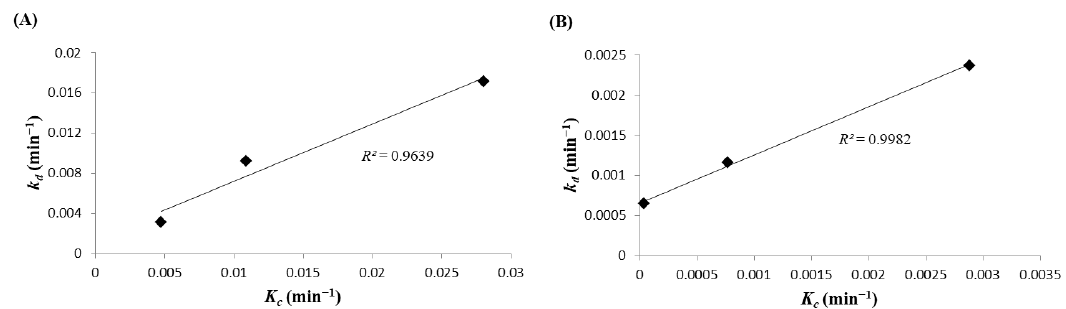
Figure 3. Relationship between crystallization rate constant K c and destabilization rate constant k d for: ( A ) rapeseed oil mayonnaise; and ( B ) soybean oil mayonnaise.